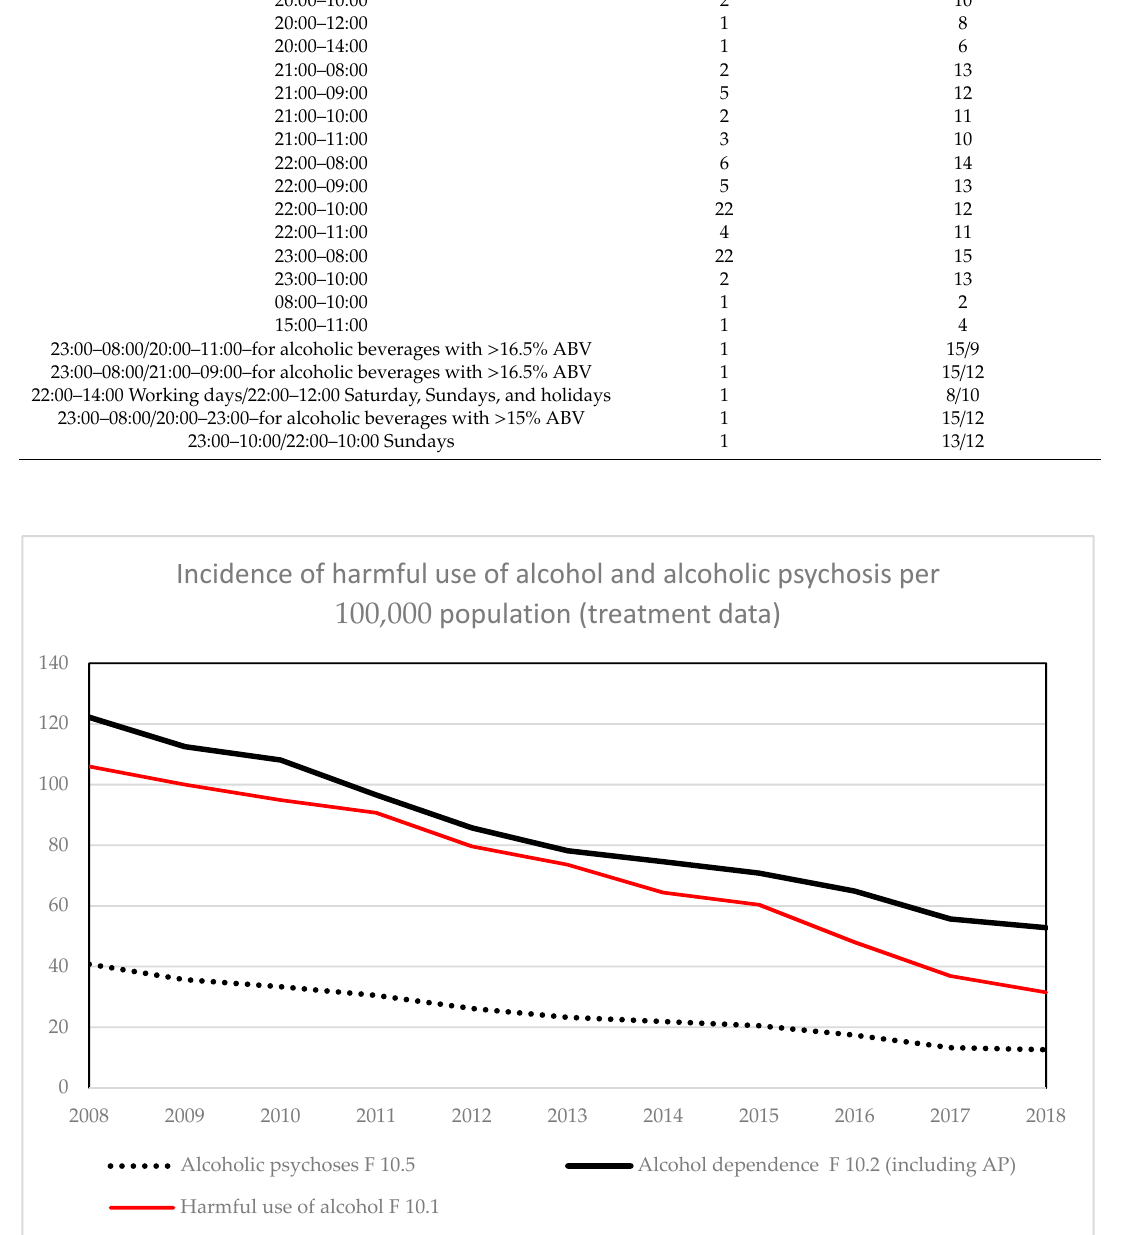
Figure A3. Incidence of alcoholic psychosis and harmful use of alcohol per 100,000 as registered within state-run narcology services. Source: Serbsky National Medical Research Centre for Psychiatry and Narcology of the Ministry of Health of the Russian Federation.